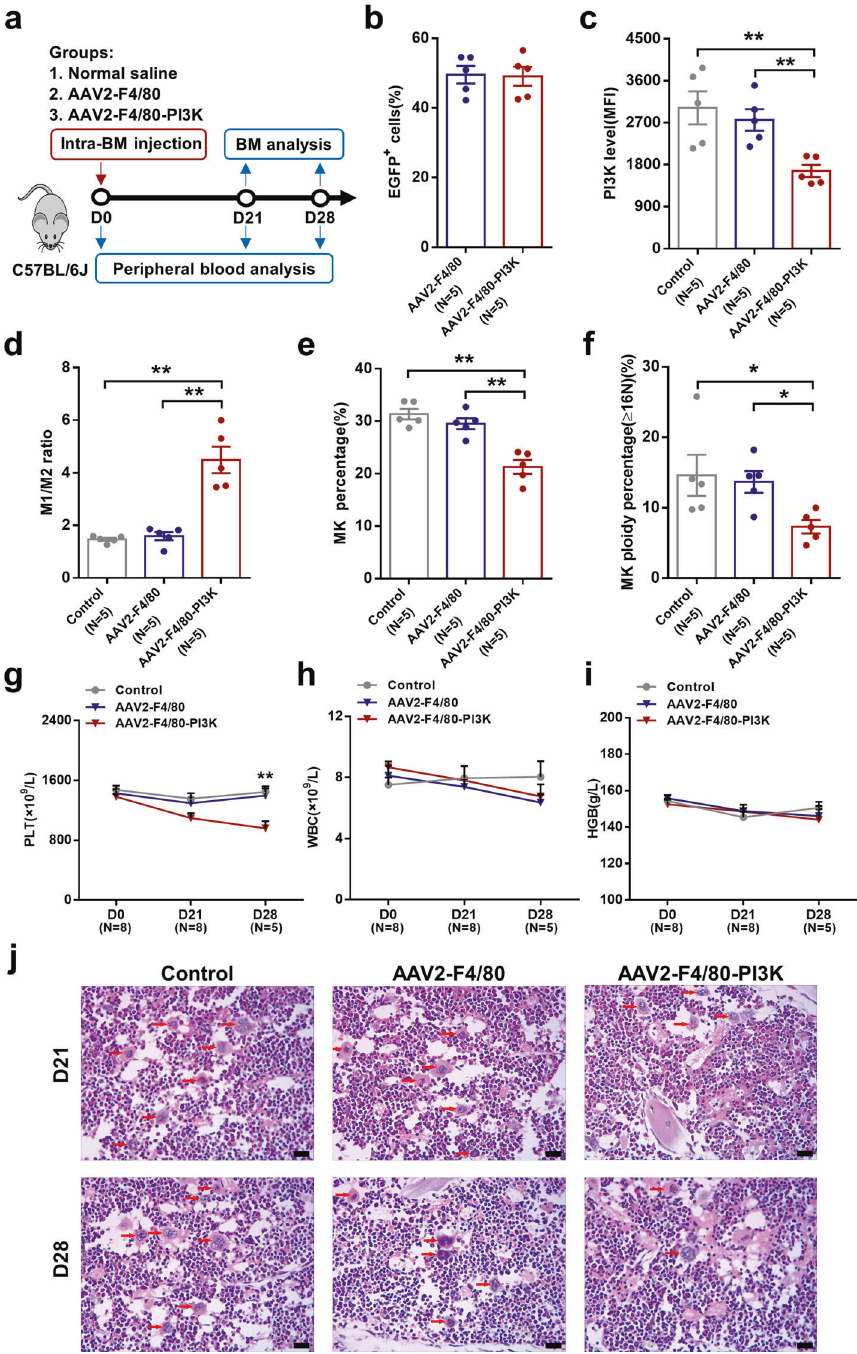
Fig. 6 Bone marrow macrophage-speci fi c PI3K-knockdown mice demonstrated a dramatic drop in megakaryopoiesis and platelet production. a Schematic diagram of the study design on BM M Ф speci fi c PI3K-knockdown mice. b Percentage of EGFP + cells in BM CD11b + F4/80 + cells of AAV2-F4/80 and AAV2-F4/80-PI3K groups. c Flow cytometry revealed the intracellular PI3K levels in EGFP + cells. d The M1/M2 ratio was calculated to represent the M Ф polarization status among control, AAV2-F4/80, and AAV2-F4/80-PI3K groups. The e percentage of MKs and f percentage of high-ploidy MKs in the BM among control, AAV2-F4/80 and AAV2-F4/80-PI3K groups. Peripheral g platelet (PLT), h white blood cell (WBC) and i hemoglobin (HGB) count among control, AAV2-F4/80 and AAV2-F4/80-PI3K groups. j The histopathological analysis of cellularity of BM MKs (×400, red arrows indicate MKs) at day 21 and day 28 after treatment. Data are presented as the means ± SEM (* P ≤ 0.05, ** P ≤